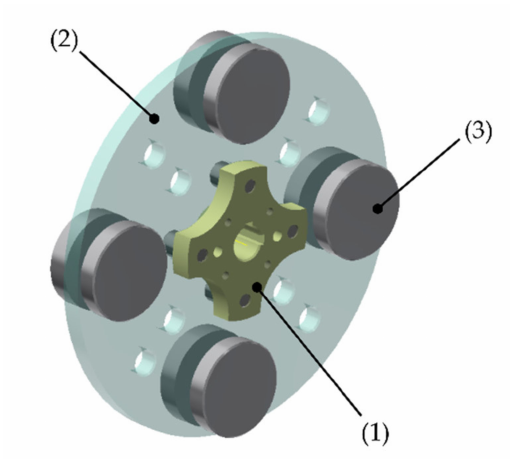
Figure 2. CAD model of the link module: (1) link coupling plate; (2) disk; (3) additional masses. Just by using two sets of masses and positioning them at the same time, that is, two occupied holes in the disk, 12 different load schemes would be obtained. The resultant external torque by (a) two sets of masses and (b) four sets of masses, located asymmetrically in the perforated disk are reported in Figure 3. It is worth noting that masses located symmetrically do not induce external torques.